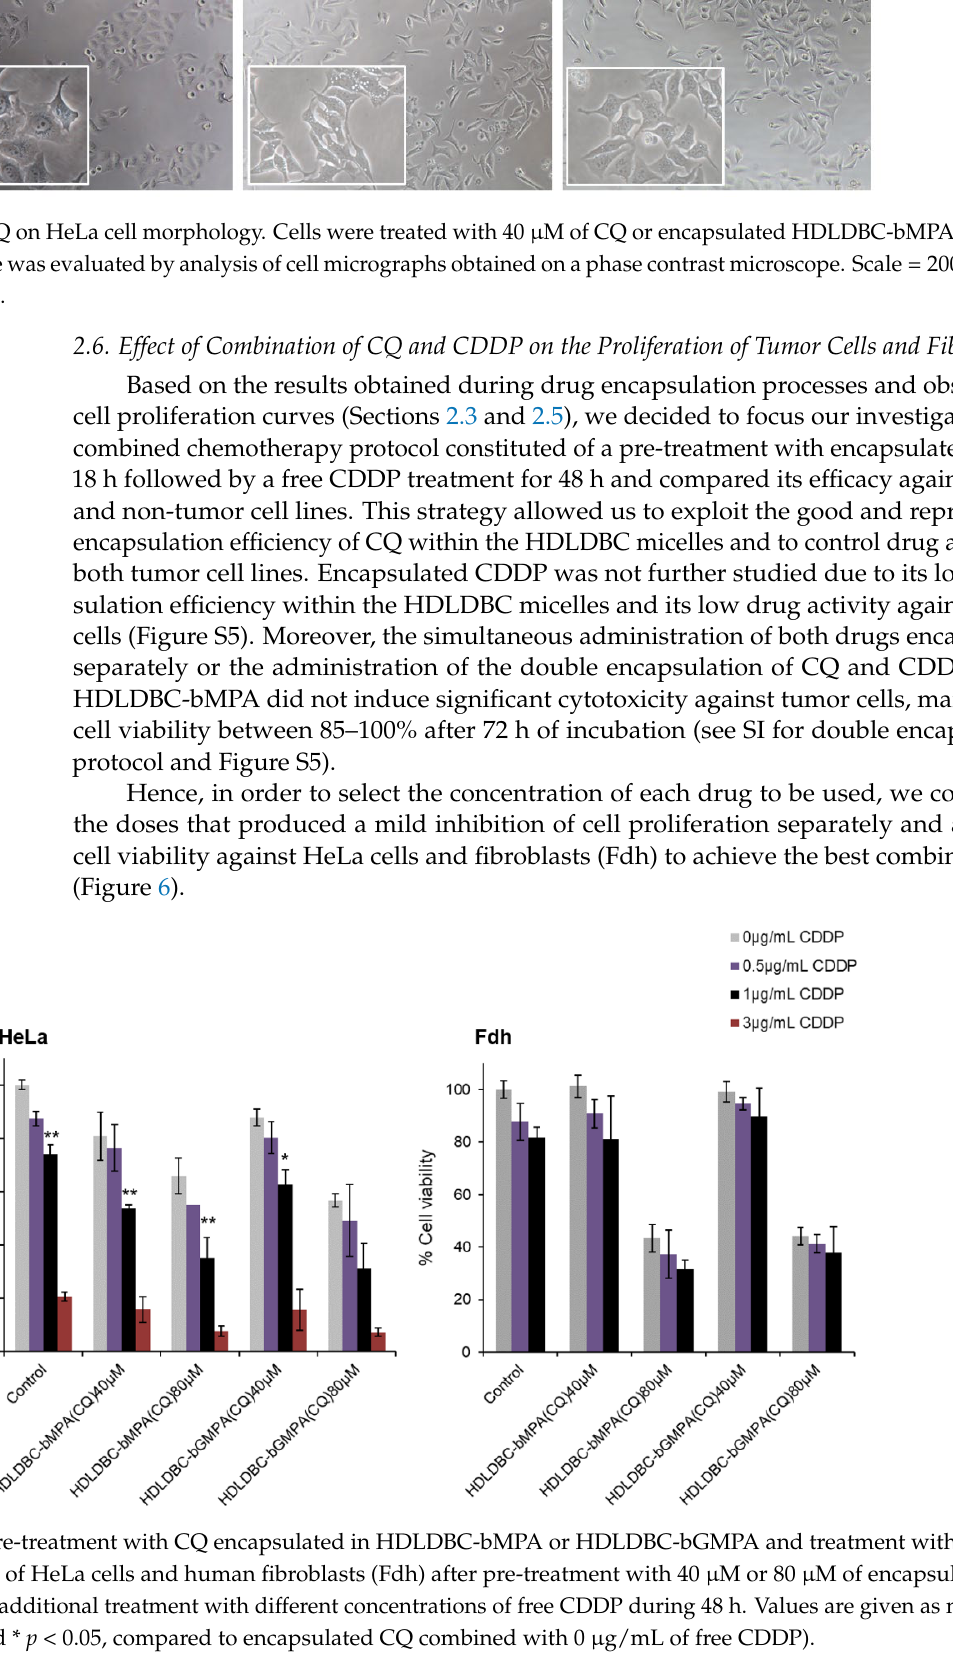
p < 0.05, compared to encapsulated CQ combined with 0 µg/mL of free CDDP).